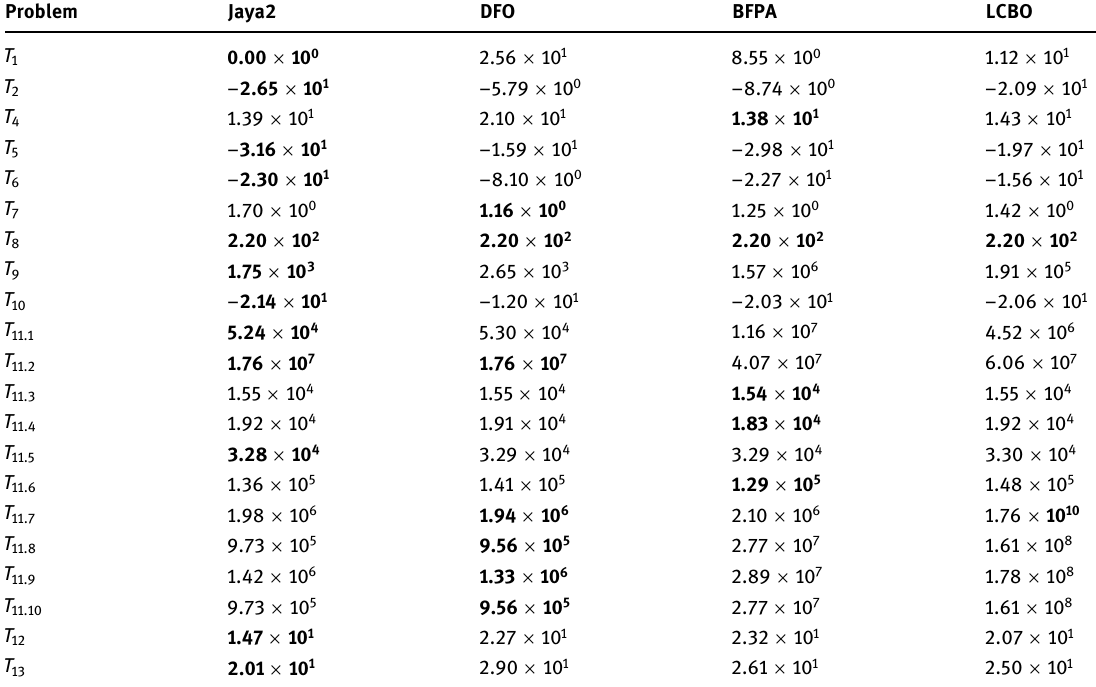
Table 11: The CEC 2011 median function values achieved by Jaya2, DFO, BFPA, and LCBO over 25 runs and 150,000 function evaluations